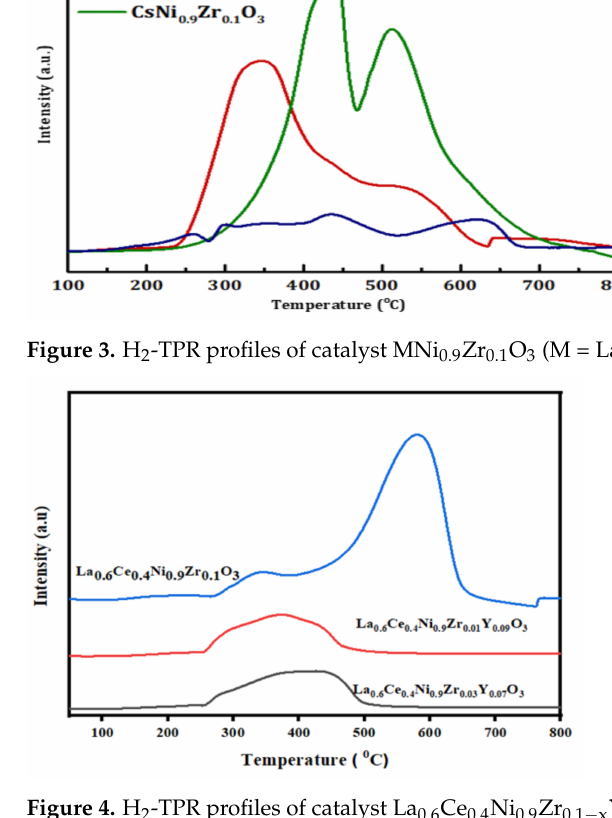
Figure 4. H 2 -TPR profiles of catalyst La 0.6 Ce 0.4 Ni 0.9 Zr 0.1 − x Y x O 3 (x = 0.05, 0.07, and